Question: What style of plot is this figure drawn as?
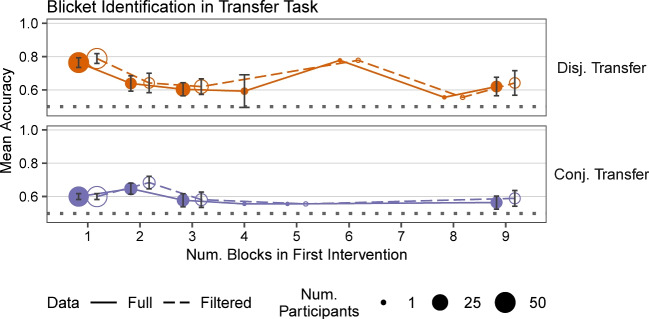
Answer: bar